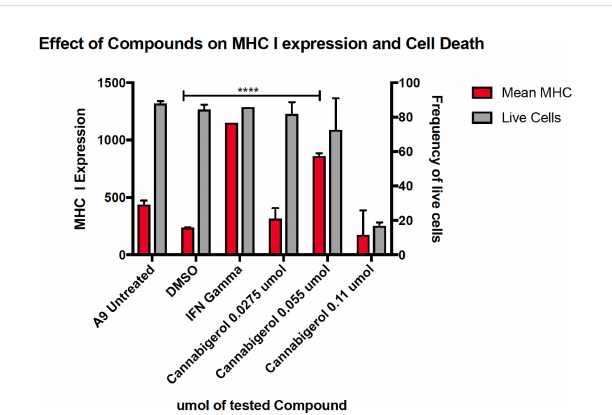
FIGURE 2 MHC-I downregulation is reversible by IFN- g or cannabigerol in metastatic murine cells. The murine lung cancer cell line, A9 was treated with various doses of CBG and compared with induction by IFN- g . MHC-I was measured by fl ow cytometry after 48 hr. In comparison to the vehicle control DMSO, signi fi cant induction (*) was demonstrated at 0.0275 µM and 0.055 µM of CBG (red) while cell viability (grey) was maintained above 70% for both concentrations of CBG. These data are representative of three independent